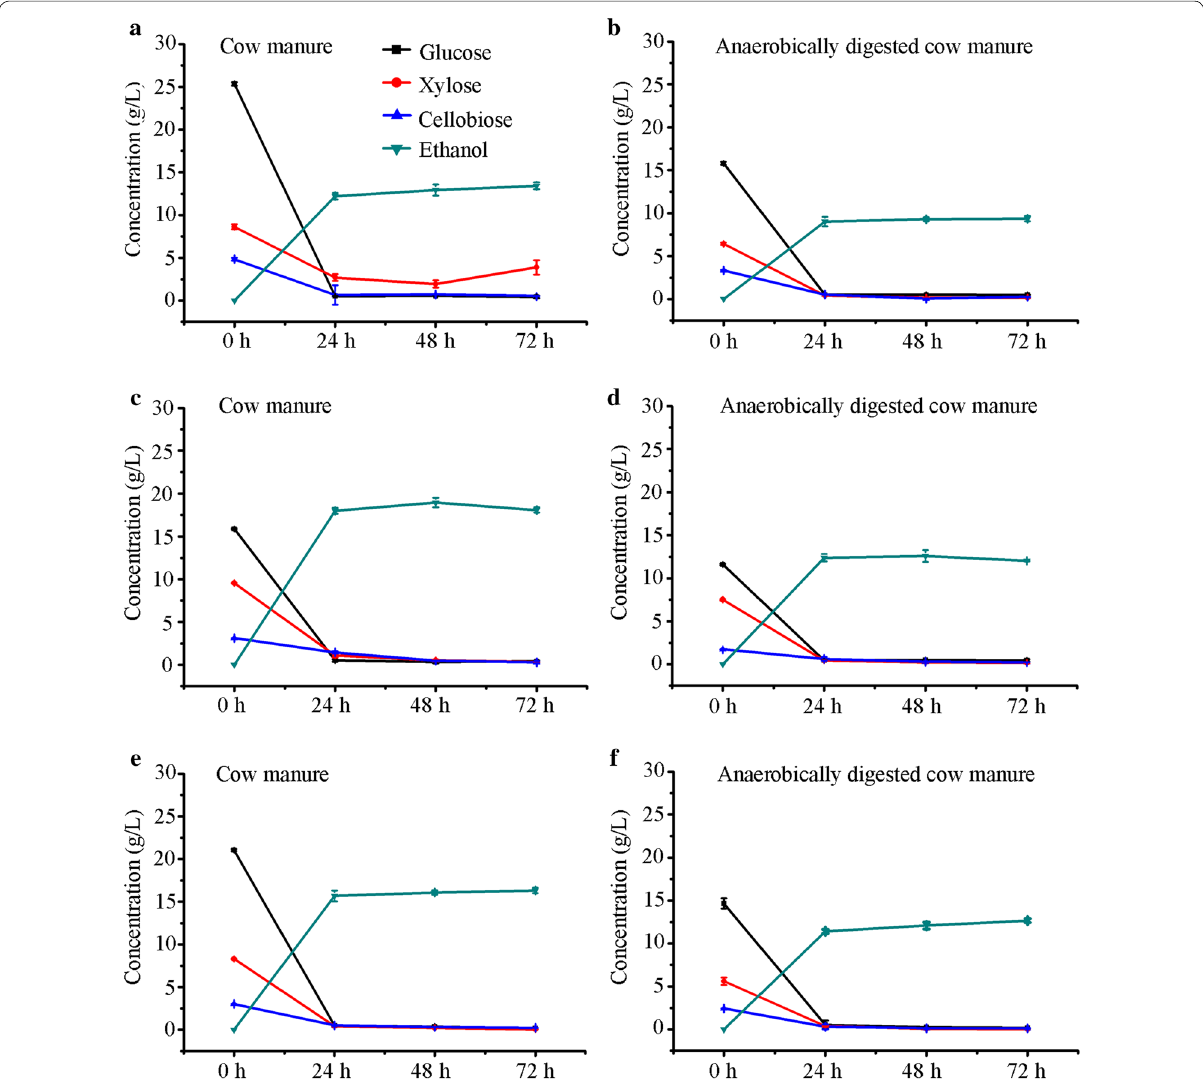
Fig. 3 Batch enzymatic hydrolysis with commercial cellulase SN-1 and ethanol production. Hydrolysis of alkali treated substrates by C1-9 cellulase ( a , b ) was compared with commercial cellulase SN-1 ( c , d ) and combined hydrolysis by mixed enzymes (50% SN1 and 50% C1-9) at solid loading of 10% and enzyme loading 20 FPU/g dried substrates ( e , f ). Glucose (solid squares), xylose (solid circles), cellobiose (solid upward-facing triangles), ethanol (solid downward-facing triangles). Data presented are averages of triplicate experiments; error bars indicate the standard